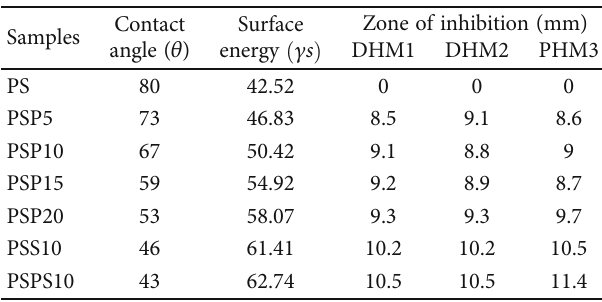
Figure 7: The antialgal analysis of various compositions of blends (PS, PSP5-20, PSS10, and PSPS10) against di ff erent algal strains (DHM1, DHM2, and PHM3). Table 3: Contact angle, surface energy, and zone of inhibition of blends (PS, PSP5-20, PSS10, and